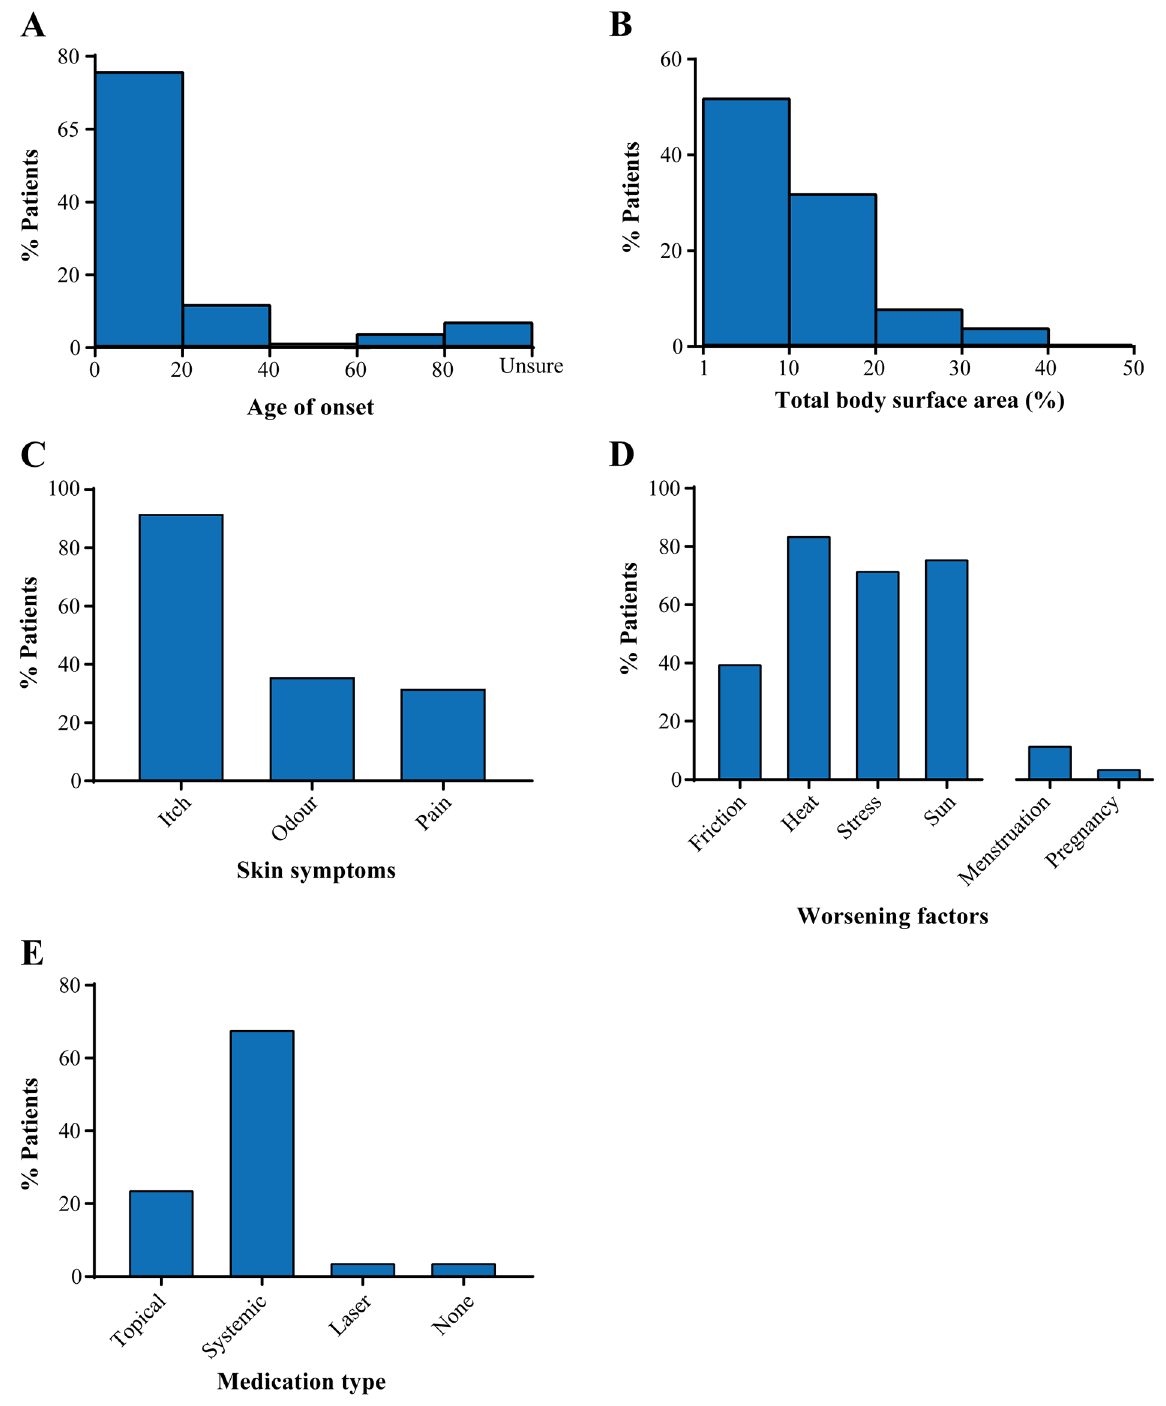
Fig 2. Clinical characteristics of the cohort. Age of onset (A), total body surface area affected (B), skin symptoms (C), worsening factors (D) and medicationtype (E) in the patient cohort.